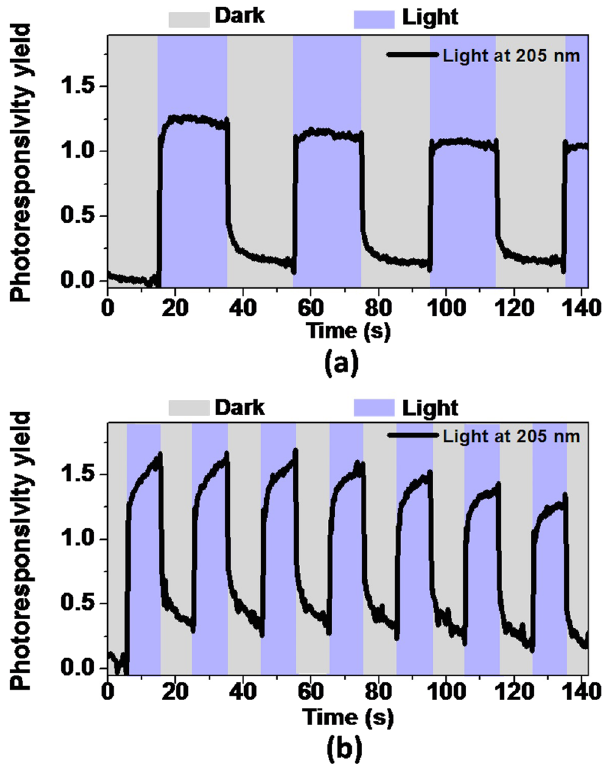
Figure 6. Response of prototypical thick BN-based photodetector (applied voltage of 100 V) under dark/light cycles ( a ) with pulse time of 20 s and ( b ) with pulse time of 10